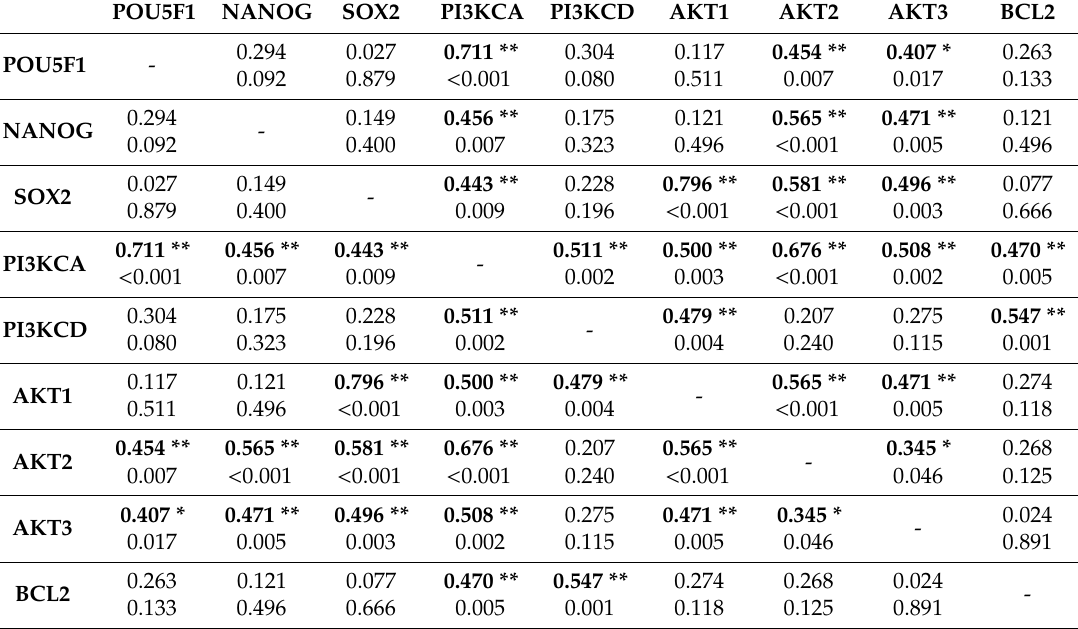
Table 1. Correlations among gene